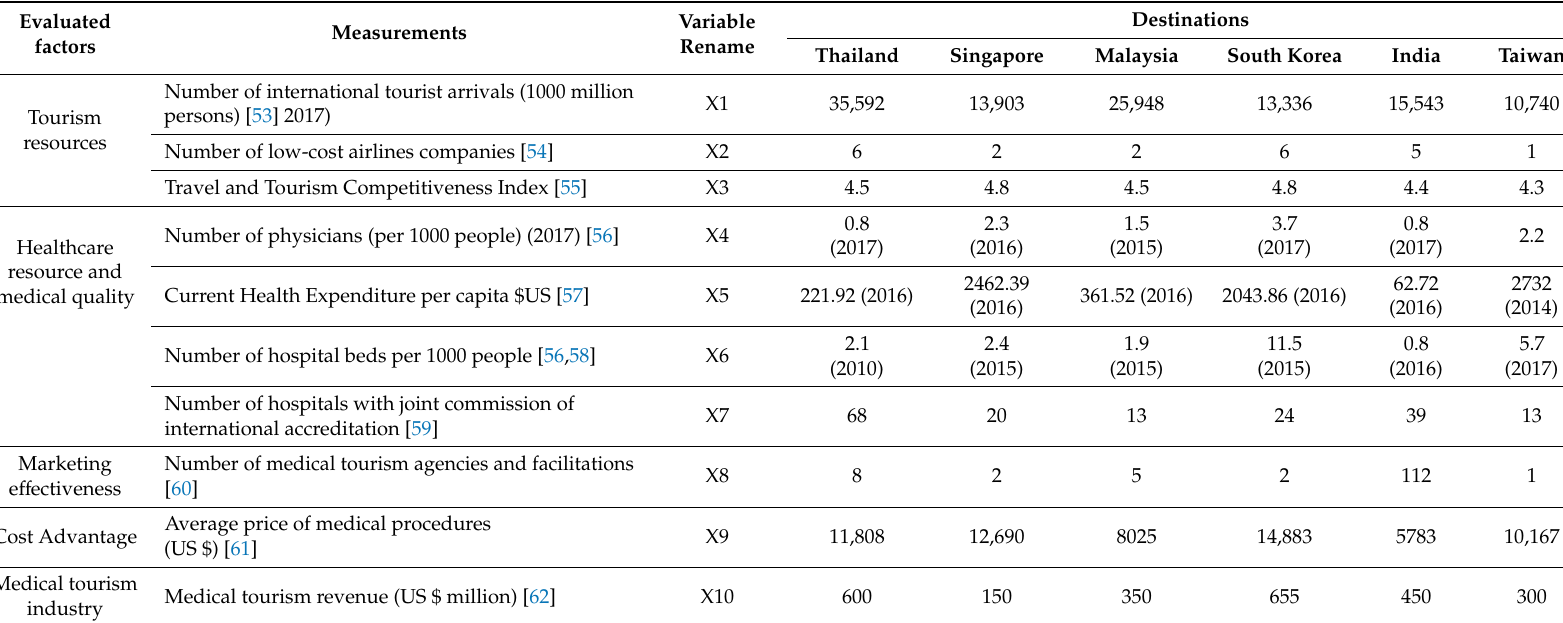
Table 1. Collected measurements and data for analyzing the impact factors of medical tourism industry in the Asia-Pacific region and evaluating performance of each